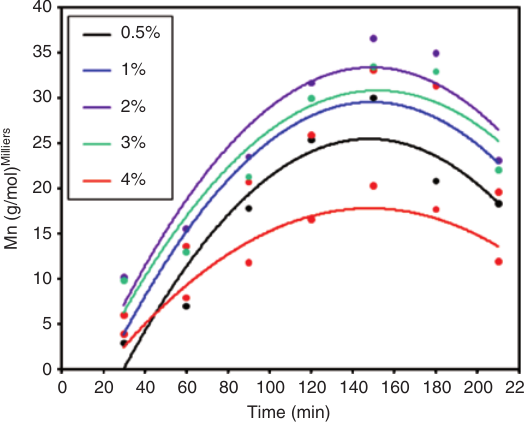
Figure 7: Effect of Maghnite-H + /tetraphenyltetramethylcyclotetra- siloxane (D 4Ph,Me ) weight ratio on the average molecular mass.